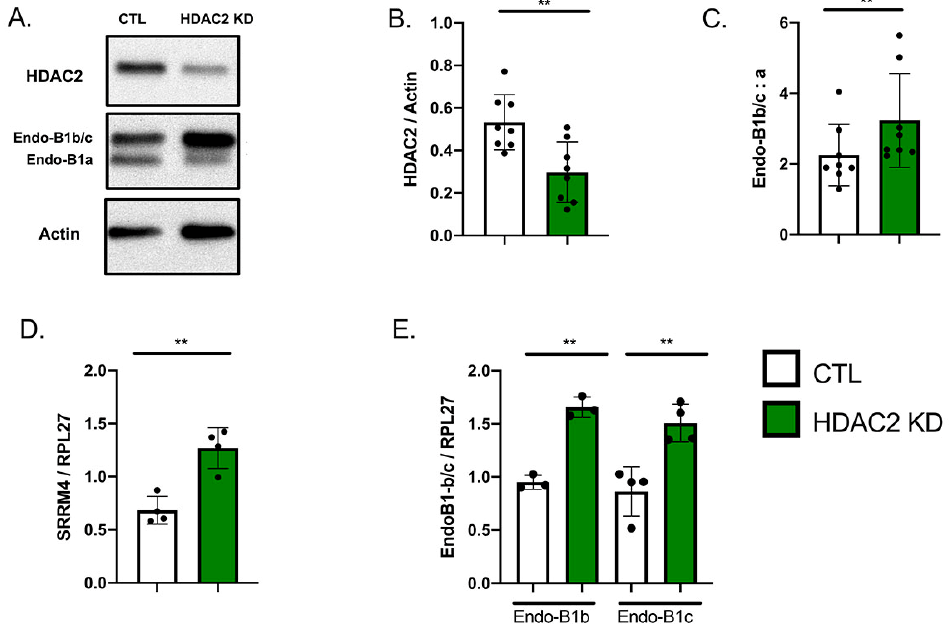
Figure 3. HDAC2 knock-down via shRNA further induces neuronal isoforms of Endo-B1 in hiPSC-derived neurons. ( A ). Representative Western blot demonstrating HDAC2 KD after lentiviral infection and resulting induction in Endo-B1b/c isoforms at the protein level. ( B , C ). Quantification of HDAC2 protein and Endo-B1b/c:a isoform ratio in 3-week differentiated neurons transduced with HDAC2 shRNA ( N = 8, ** p < 0.01 by t -Test). ( D ). HDAC2 KD induces SRRM4 mRNA expression. ( E ). HDAC2 KD induces Endo-B1b and Endo-B1c mRNA expression (Each dot represents the mean of 3–4 independent experiments, ** p < 0.01 by t